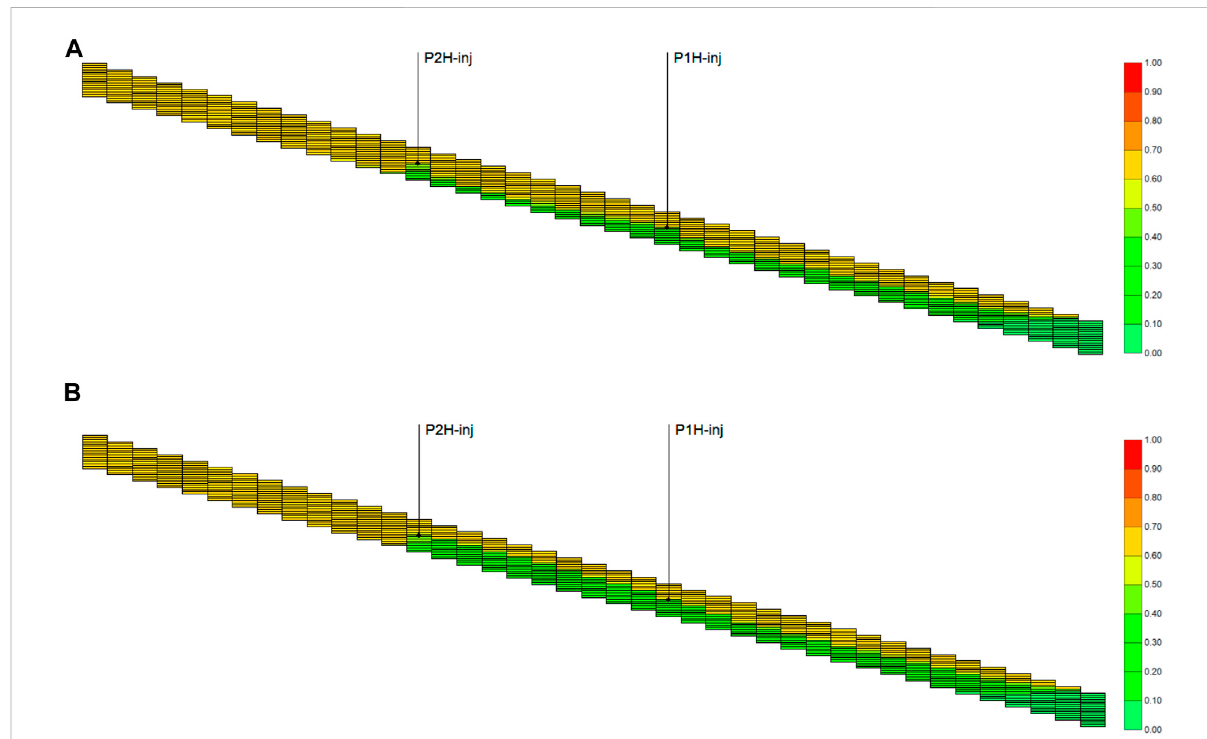
FIGURE 9 Oil saturation before and after the well-to-well interplay of CO 2 huff-n-puff. (A) Before and (B) after the well-to-well interplay of CO 2 huff-n-